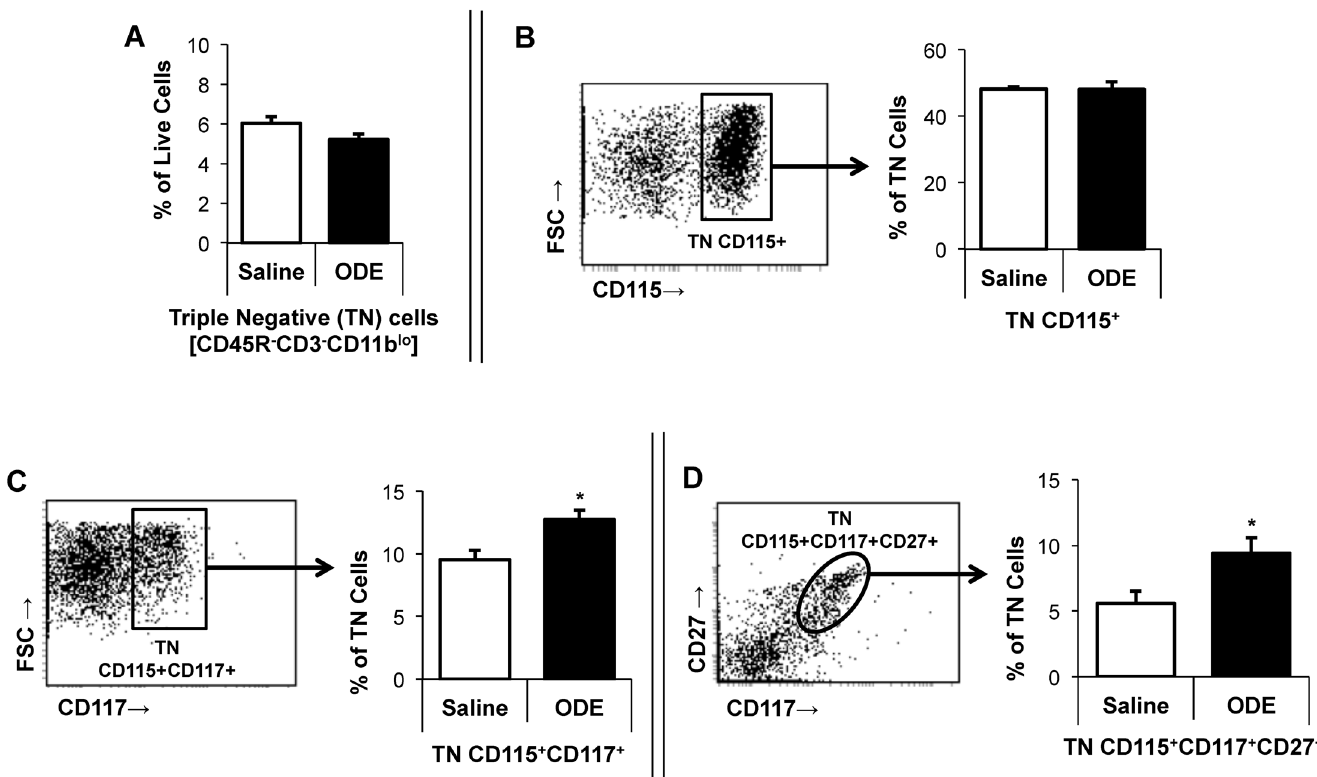
Fig 7. Inhalant exposure with organic dust extract (ODE) increases osteoclast precursor populations (OCP) in murine bone marrow cells. WT mice were i . n . treated with saline or ODE daily for three weeks whereupon mice were euthanized and bone marrow cells were collected and analyzed by flow cytometry. After exclusion of debris and dead cells, triple negative (TN) cells were gated based upon CD45R - CD3 - CD11b lo phenotype with panel A depicting the frequency of TN cells as a percentage of live cells in a bar graph. Panel B depicts a representative dot plot of TN cells expressing CD115 with associated frequency distribution shown in bar graph. Next, representative dot plots with frequency distribution of osteoclast precursor populations: TN CD115+CD117+ ( panel C ), and TN CD115+CD117+CD27+ ( panel D) are shown. All bar graphs represent mean percentage with SEM bars. N = minimum of 6 mice/group from three independent experiments. Statistical significance denoted as asterisks ( * p < 0.05) vs.